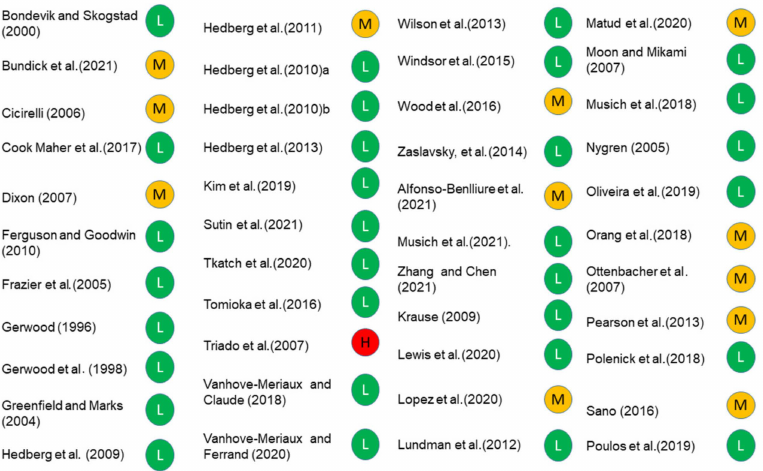
Figure 3. RoB of included